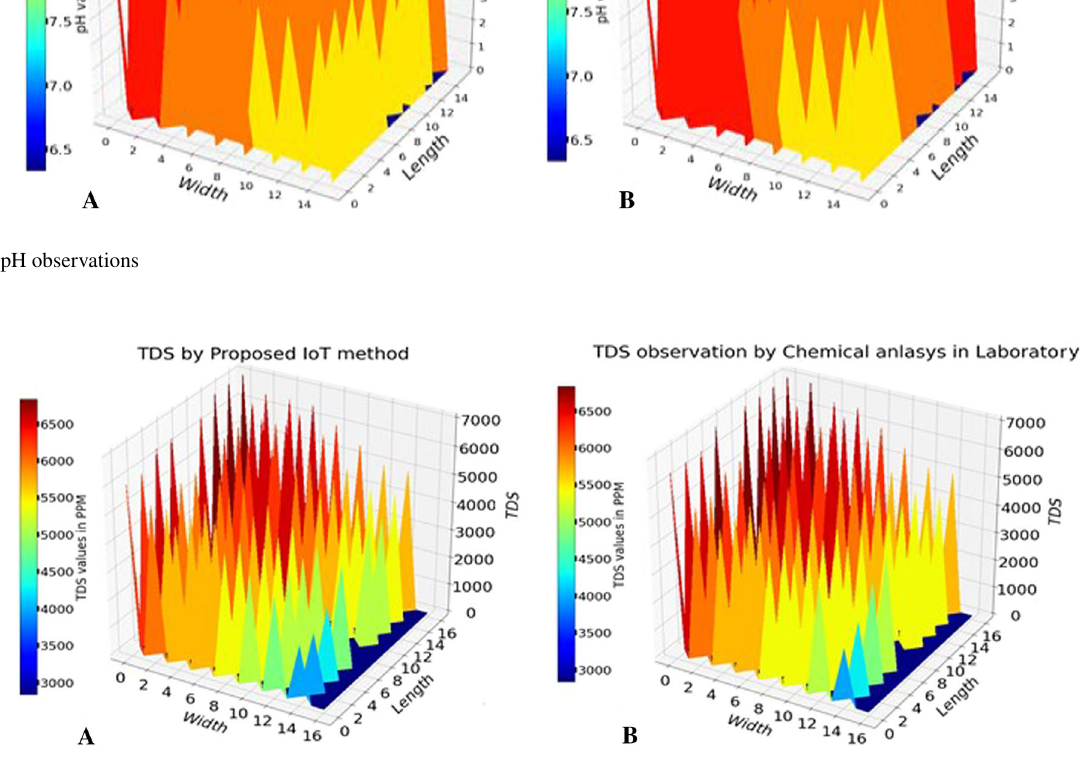
Fig. 11 TDS observations